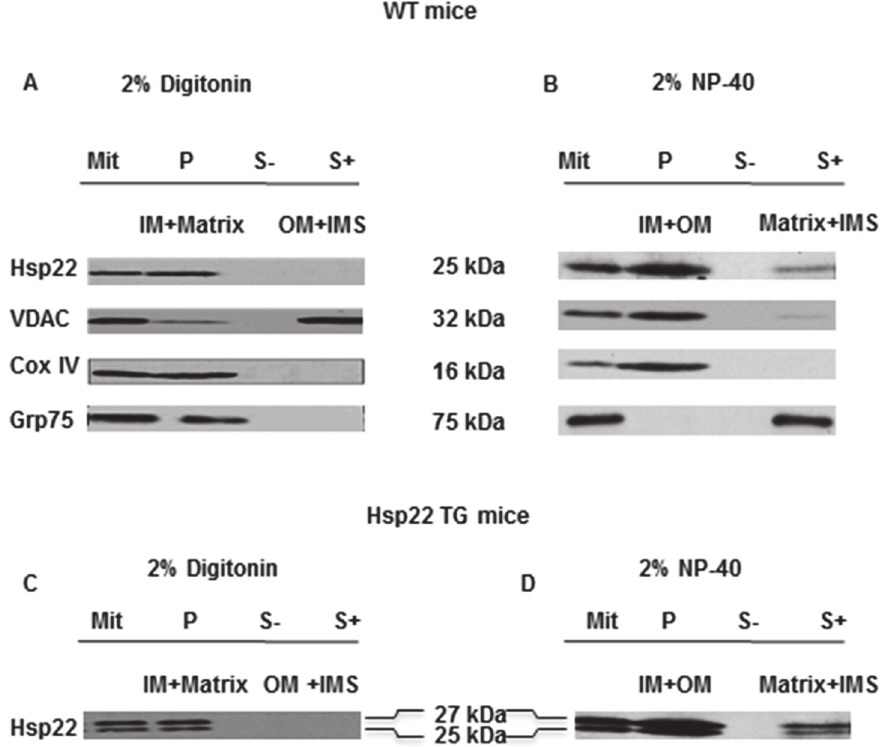
Fig 1. Sub-mitochondrial localization of Hsp22 in mouse heart. Mitochondrial sub-fractionation was performed on WT (A and B) and TG mouse hearts (C and D) after treatment with digitonin (A and C) and NP- 40 (B and D). In each panel, from left to right: Mit: untreated total mitochondria (positive control); P: pellet obtained from detergent-treated mitochondria; S-: supernatant obtained after centrifugation of untreated mitochondria (negative control); S+: supernatant obtained after treatment. In panels A and C, digitonin treatment shows that Hsp22 is distributed in the pellet (P) containing the IM and matrix but not in the supernatant (S+) containing the OM and IMS. In panels B and D, NP-40 treatment shows that Hsp22 is predominantly located in the pellet (P) containing the IM and OM, and to a low extent in the supernatant (S+) containing the matrix and IMS. Markers include VDAC (OM), COX IV (IM), and Grp75 (matrix). The figure shows one representative example of n = 4 per